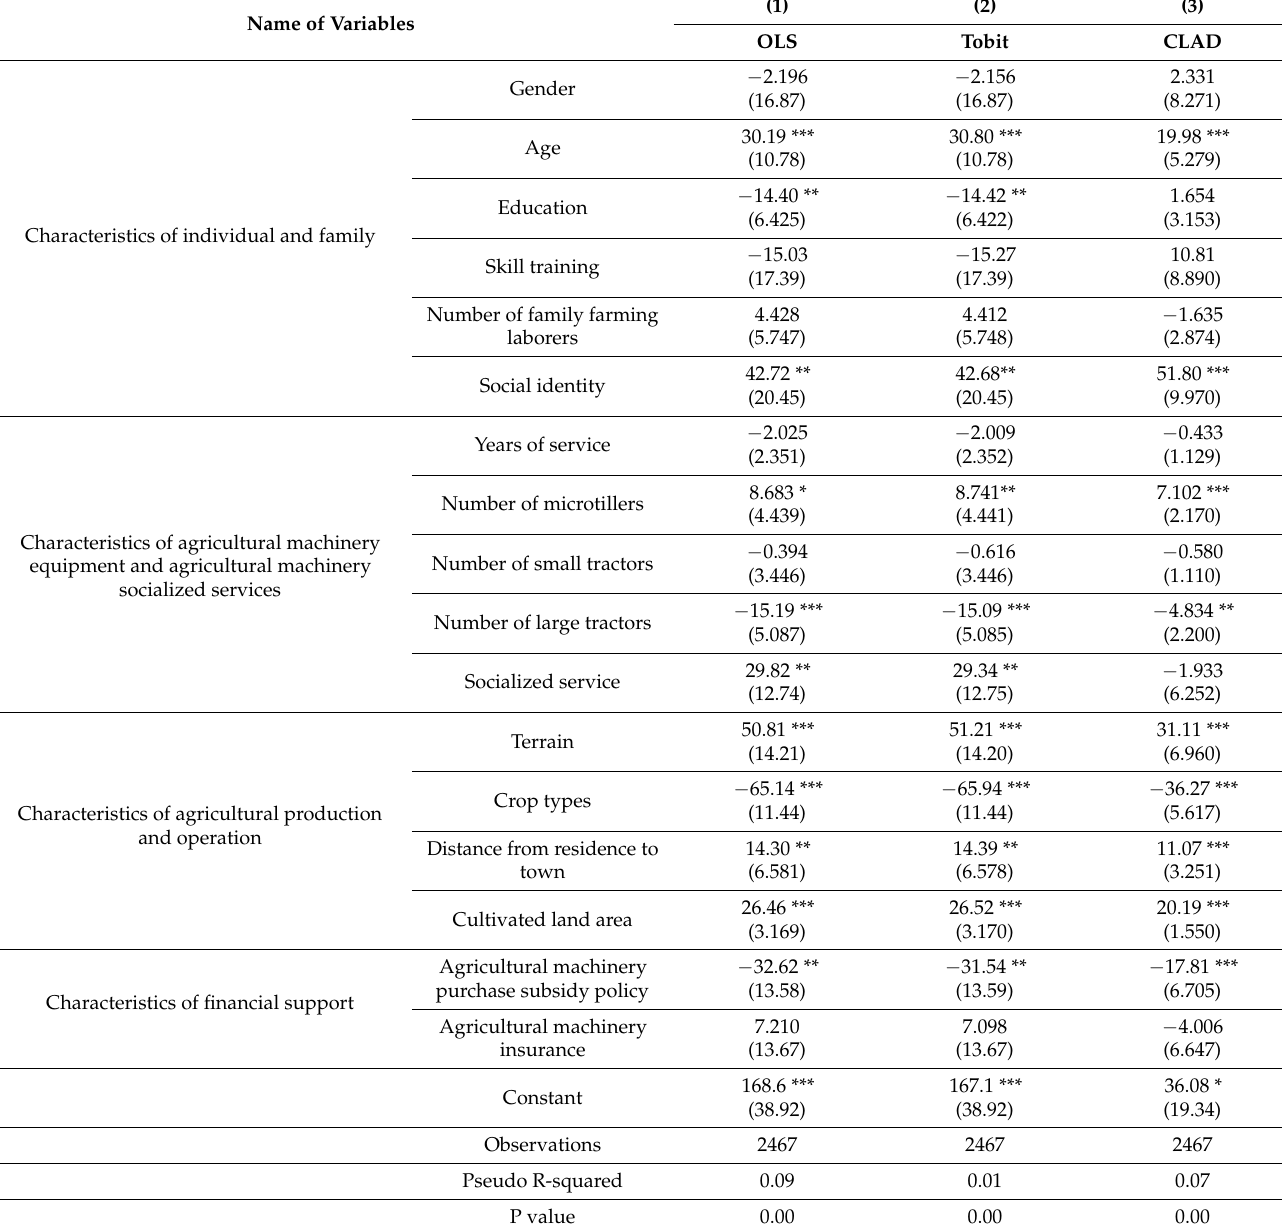
Table 3. Estimation results for OLS, Tobit and